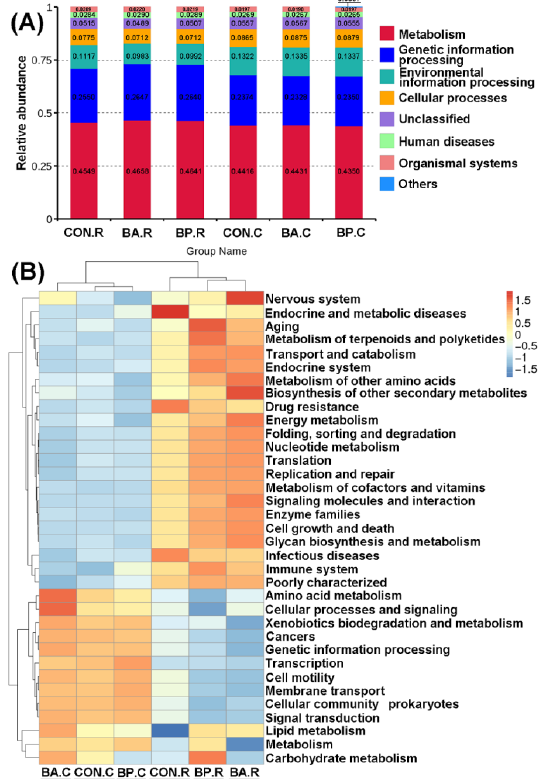
Figure 6. Estimation for Kyoto Encyclopedia of Genes and Genomes (KEGG) paths of microbial communities by the Tax4Fun program. ( A ) KEGG pathway of microbial communities at the level 1 and ( B ) Heatmap of predicted functions of microbial communities at KEGG level 2. BA.R, BP.R, and CON.R indicate rumen content samples of BA-treated, BP-treated, and control groups, respectively. BA.C, BP.C, and CON.C indicate caecum feces samples of BA-treated, BP-treated, and control groups, respectively.